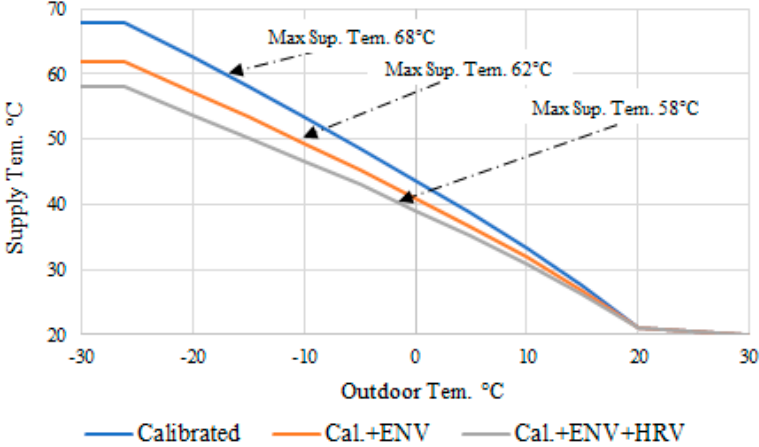
Figure 11. The heating curve for different renovation measures.